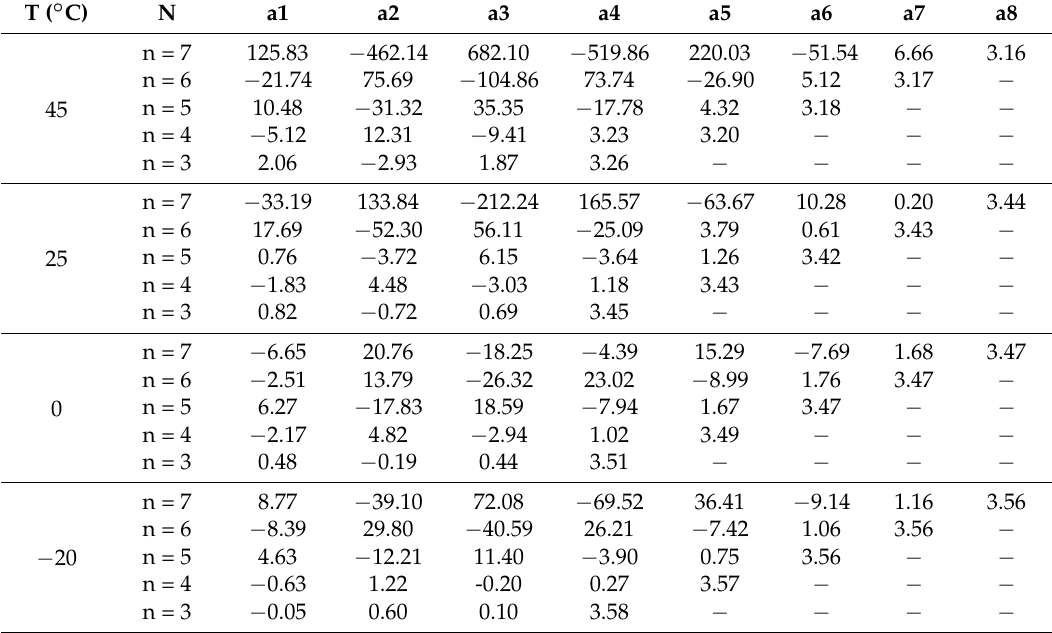
The coefficient value of OCV-SOC polynomials fitting with different orders and different temperatures.